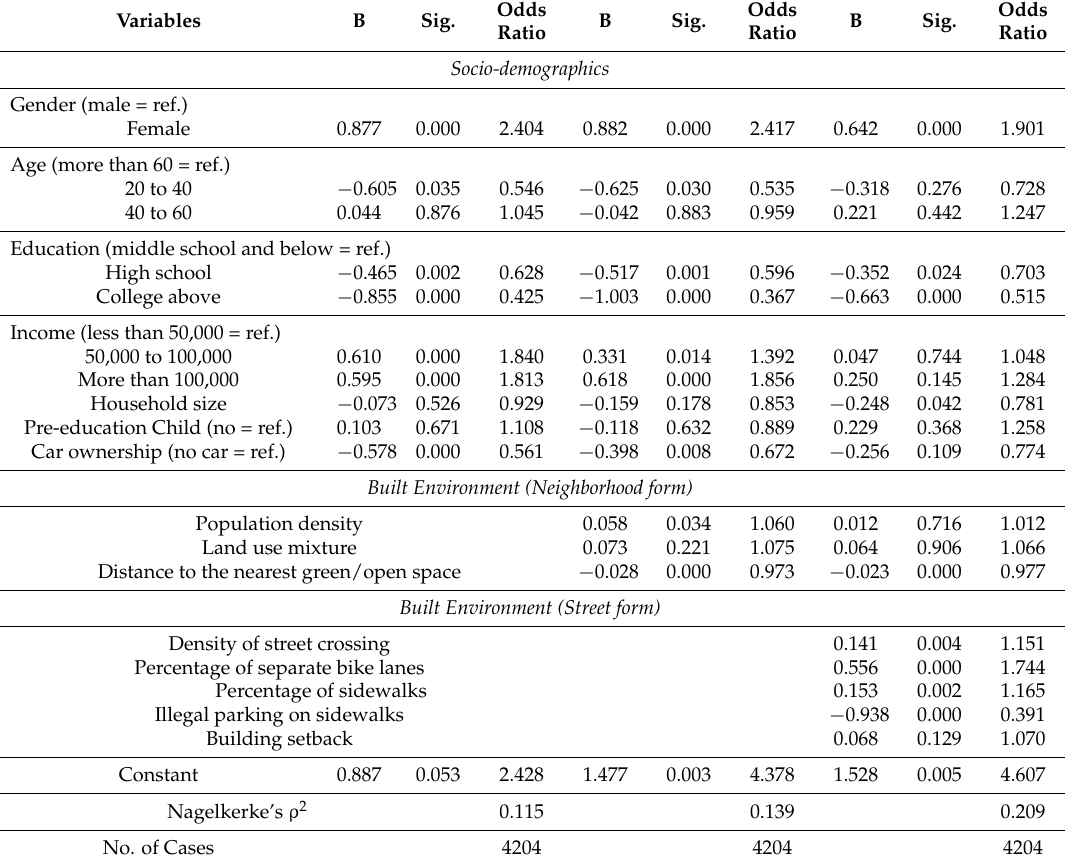
Table 4. Binary logistic model for subsistence